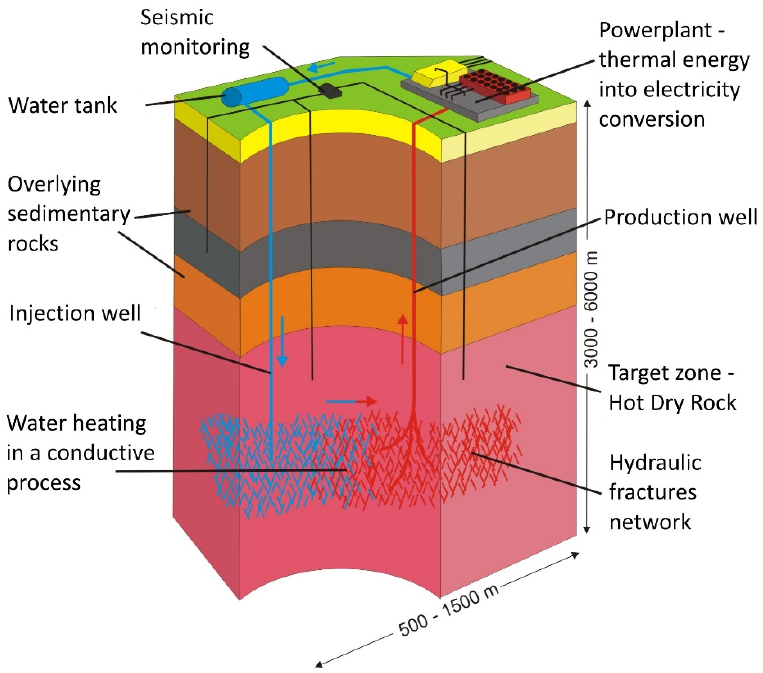
Figure 1. Principle of operation of a doublet enhanced geothermal system.